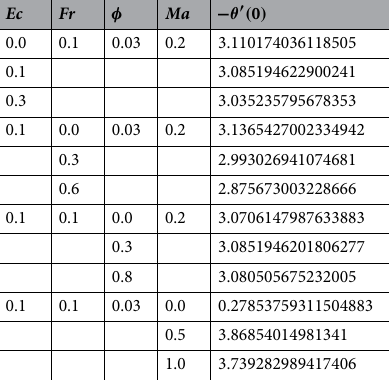
Table 1. Computational outcomes of nusselt number for Ec , Fr , φ and Ma .